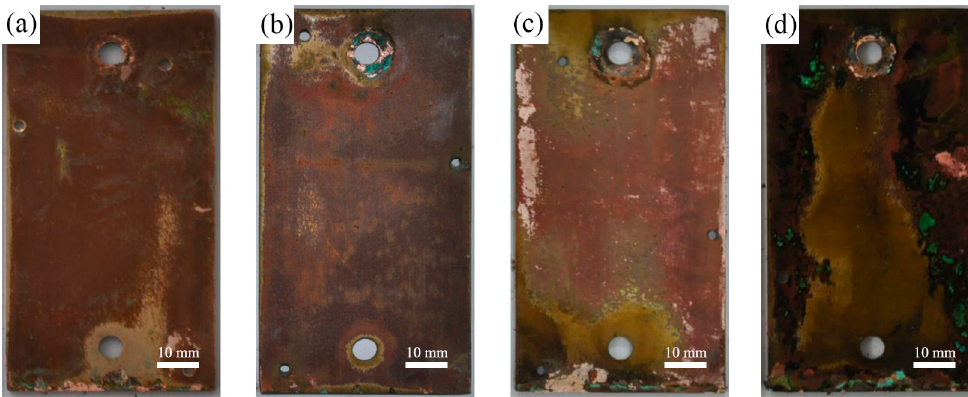
Figure 4. The macroscopic surface morphologies of Cu-Ni alloy after corrosion for ( a ) 7 d, ( b ) 14 d, ( c ) 28 d, and ( d ) 56 d (before removing the corrosion products). ( c ) 28 d, and ( d ) 56 d (before removing the corrosion products).